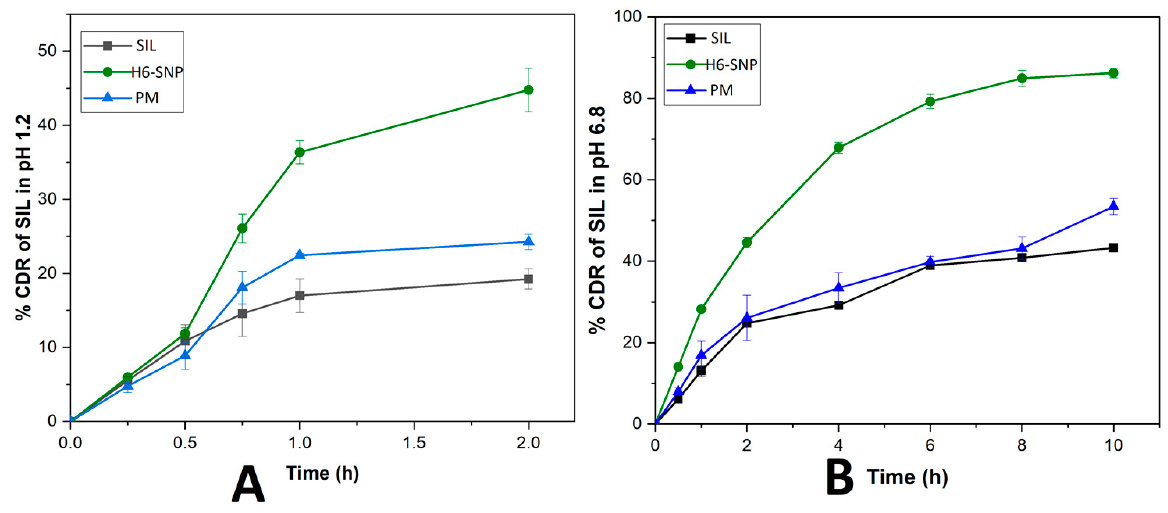
Figure 13. In vitro dissolution profile of SIL, PM and H6-SNP at pH 1.2 ( A ) and pH 6.8 ( B ). The results are expressed as mean ± SD, n = 3.